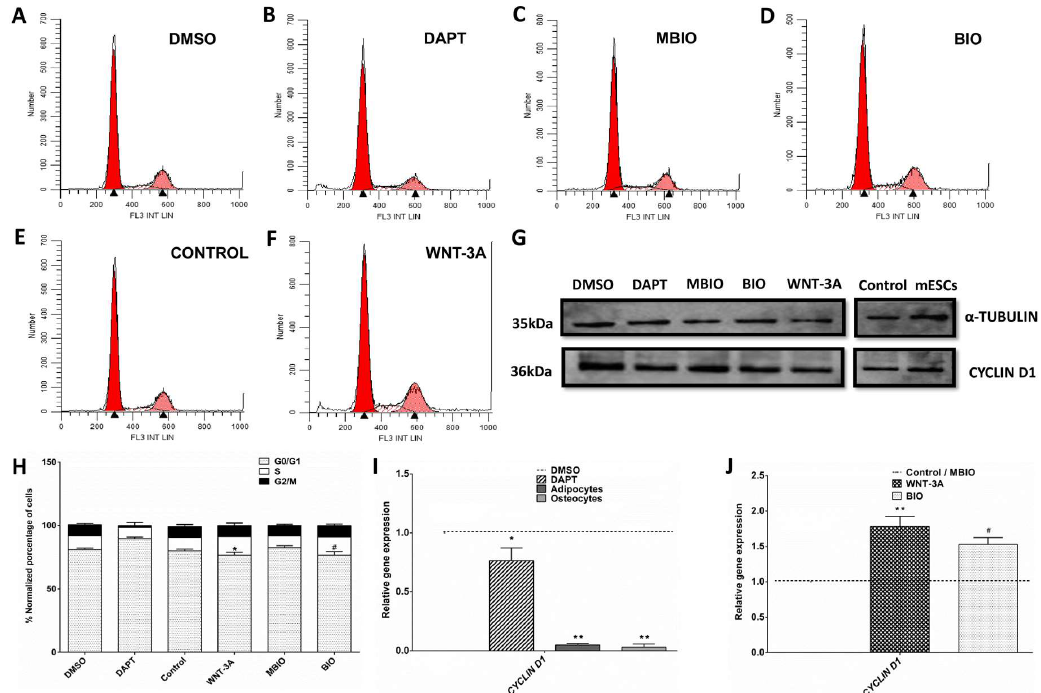
Figure 2. Notch / Wnt treatment e ff ect over cell cycle in DPSCs. ( A – F ): Flow cytometry analysis of DPSC cultures exposed to di ff erent conditions for 48 h (DMSO, DAPT, MBIO, BIO, WNT-3A). Control ( E ) represents DPSCs grown in standard medium. ( G ): Western Blot showing CYCLIN D1 protein expression in the di ff erent conditions. ( H ): Representation of the percentage of cells in the di ff erent cell cycle phases (G0 / G1, S, G2 / M) under each condition. Data are presented as the mean + SEM ( n = 8). ( I ) Q-PCR analysis of CYCLIN D1 transcript expression in DPSCs exposed to DAPT or terminal adipogenic and osteogenic cell di ff erentiation treatments, with respect to controls (dashed line). ( J ) Q-PCR analysis of CYCLIN D1 transcript expression in BIO and WNT-3A-treated DPSCs with respect to their respective controls MBIO / PBS (dashed line). Data are normalized to reference β -ACTIN and GAPDH levels and presented as the mean + SEM ( n = 3). *: p < 0.05; **: p < 0.01; ***: p < 0.001. Dunn’s Test, Kruskal- Wallis H Test. Asterisks (*) report significance with respect to controls PBS / DMSO, and Hash symbol (#) represents significance with respect to control